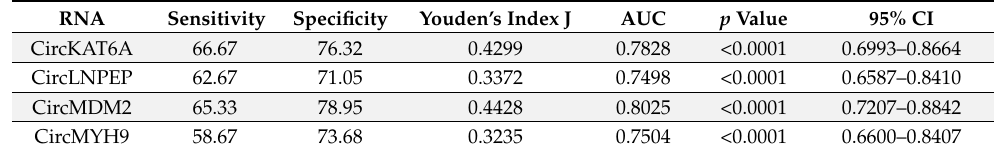
Table 2. Diagnostic performance of circRNAs in CLL.